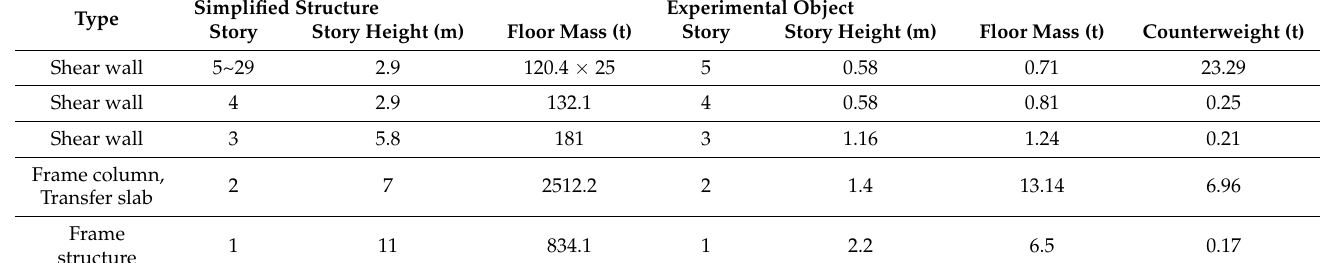
Table 2. Similar relationship.